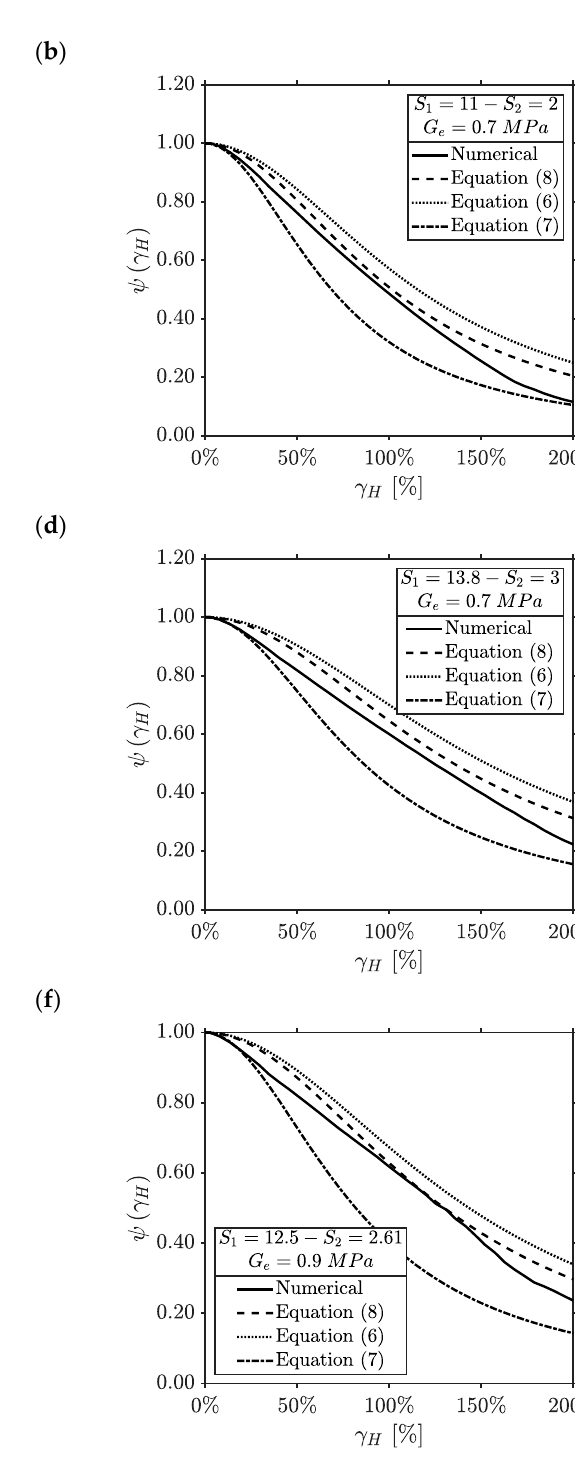
Figure 7. The 2D analytical vs. numerical trends of the ψ function for different values of the primary ( c , d ) and secondary ( a , b ) shape factors and of the shear modulus of the rubber ( e , f ). The numerical results confirm the trends of the ψ function with the main geometric and mechanical parameters of the U-FREIs